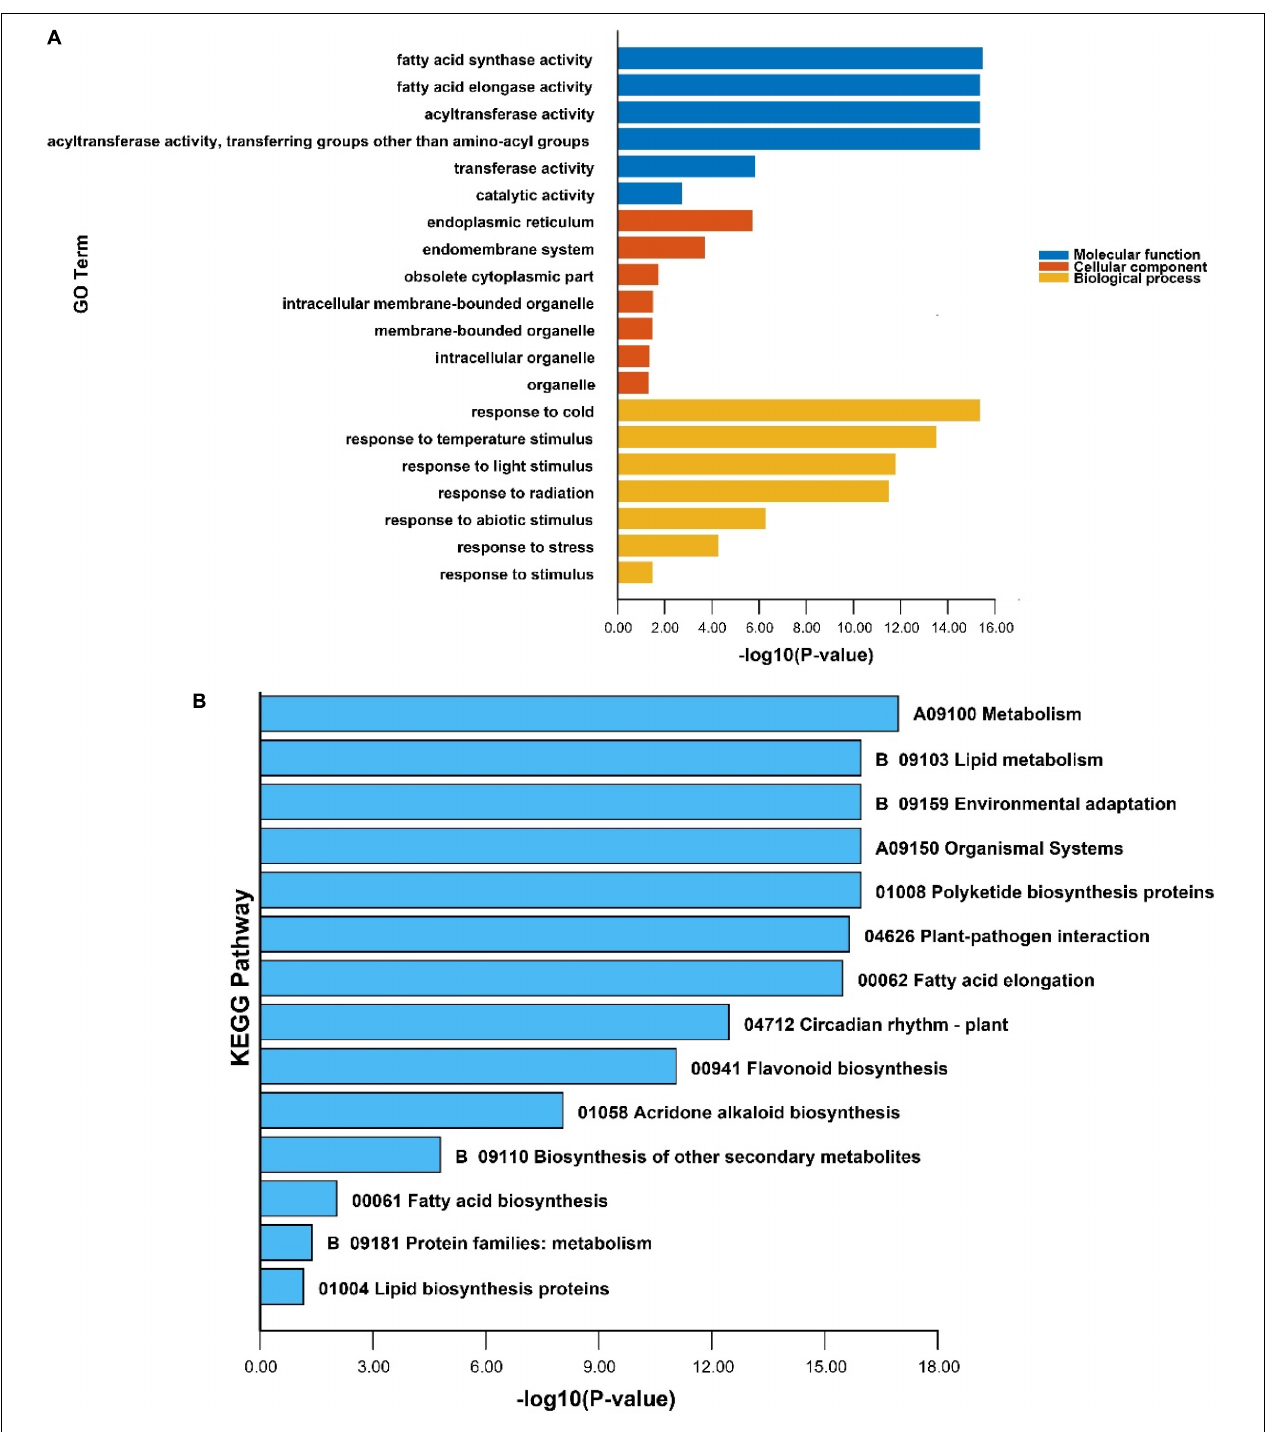
FIGURE 9 | GO and KEGG enrichment analysis of PeKCS genes. (A) The highly enriched GO terms in PeKCS genes. (B) The highly enriched KEGG pathways in PeKCS genes. Details about GO annotation, enrichment and terms of MF, CC, BP, and KEGG pathways can be found in Supplementary Tables 11 , 13a,b .